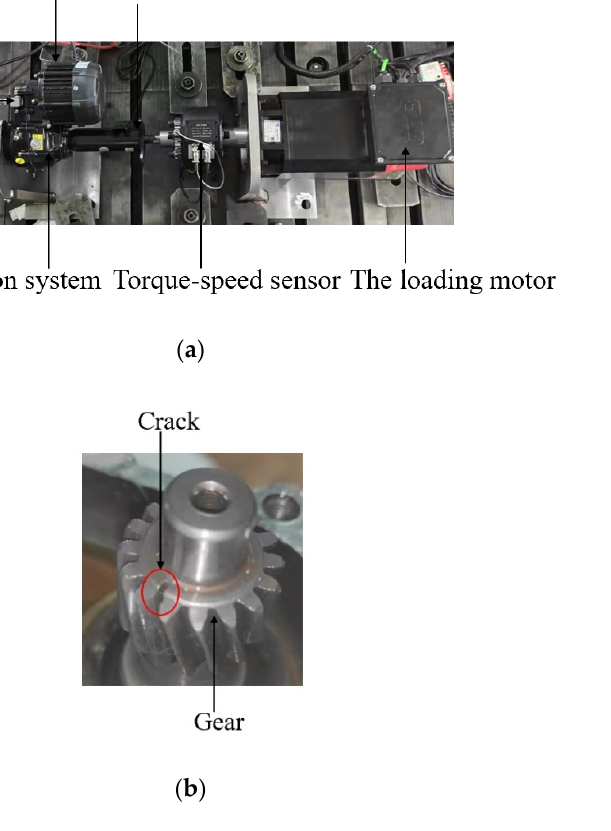
Figure 9. The test rig. ( a ) The helical gear test rig. ( b ) The gear with crack fault. The accelerometer SAE30001 made in Shi’ao Technology is used in this system. The voltage sensitivity is 500 Mv/g. The vibration accelerometer is installed at the bearing of the two ‐ stage drive system near the first driving gear on the gearbox. The sampling fre ‐ quency of the accelerometer used is 40 kHz. After working for 10 min, with the system working stablely, data is sampled for approximately 2 min.